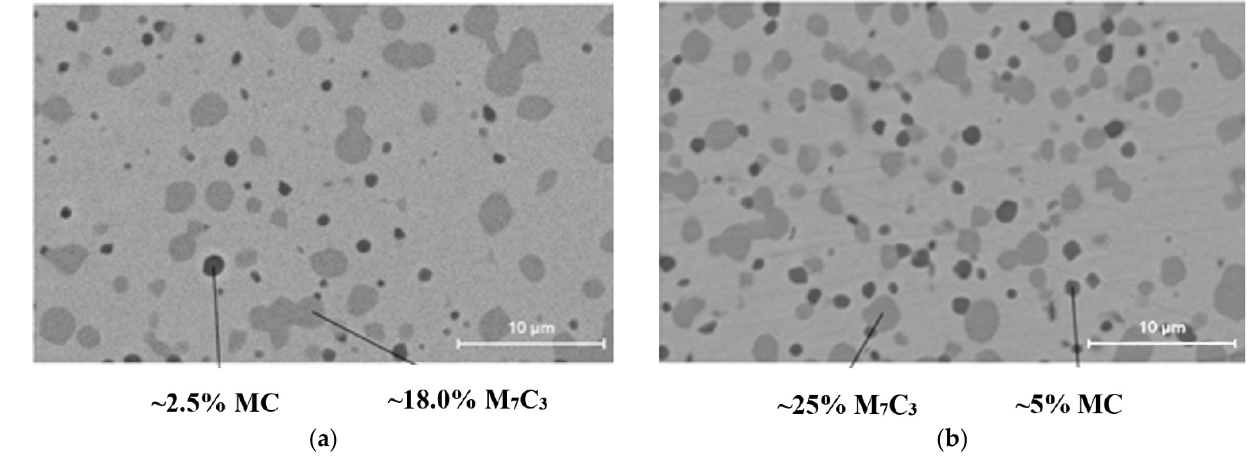
Figure 1. Microstructure of tool steels (Q + T): ( a ) M390; ( b ) M398 [13].